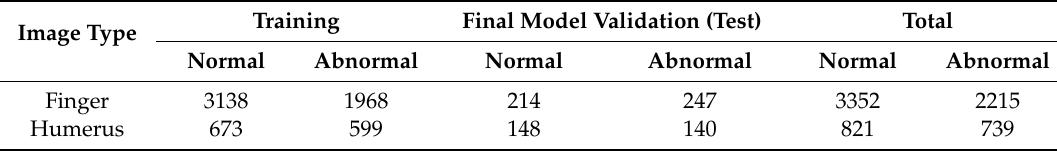
Table 1. Images from MURA dataset were split into training and test sets.